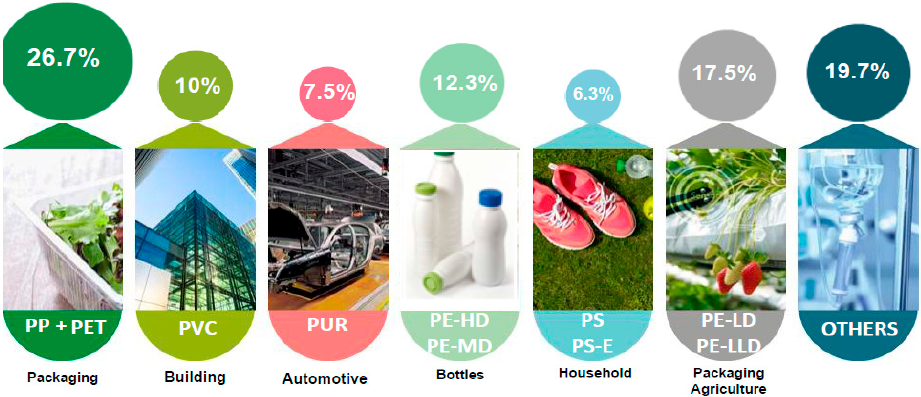
Figure 1. Worldwide plastic demand by polymer type. Adapted from reference [3].